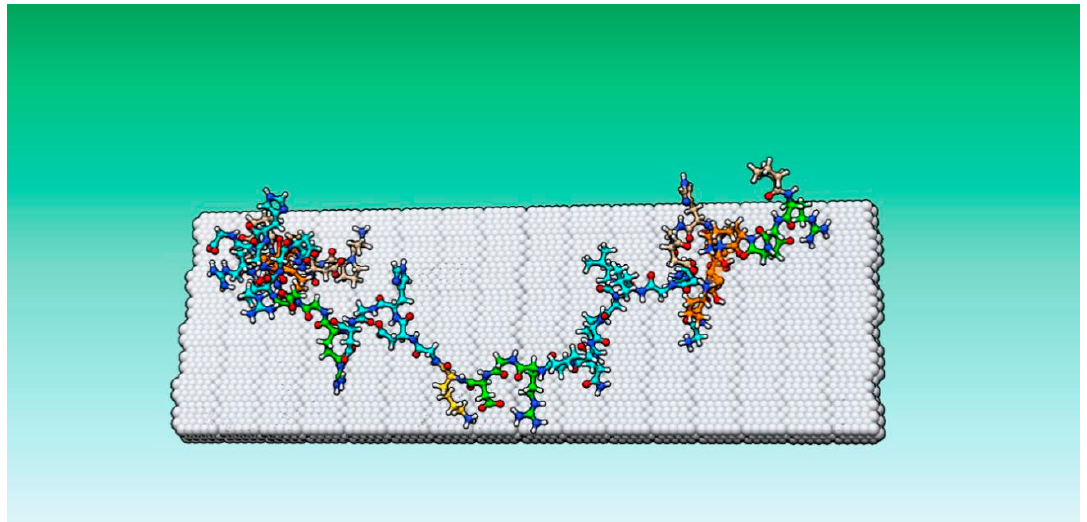
Figure 2. GelMA against titanium surface, this trimer is composed of two shorter gelatin fragments shown in orange (residues 81–89 and 183–192) the longer fragment (173–200) is colored cyan. Lysine residues are colored beige and integrin-binding RGD sequences are green.